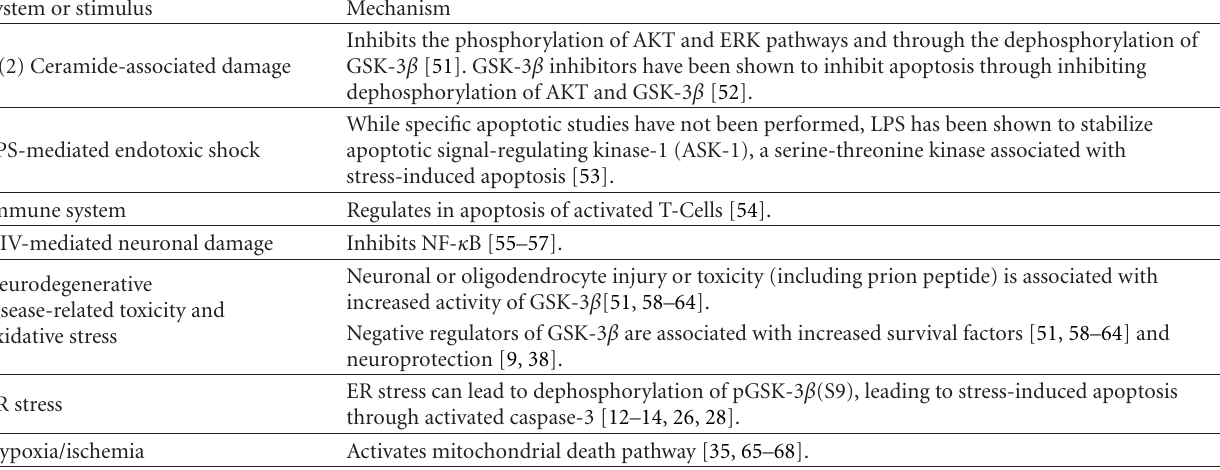
Table 1: Conditions where GSK-3 β facilitates apoptosis.